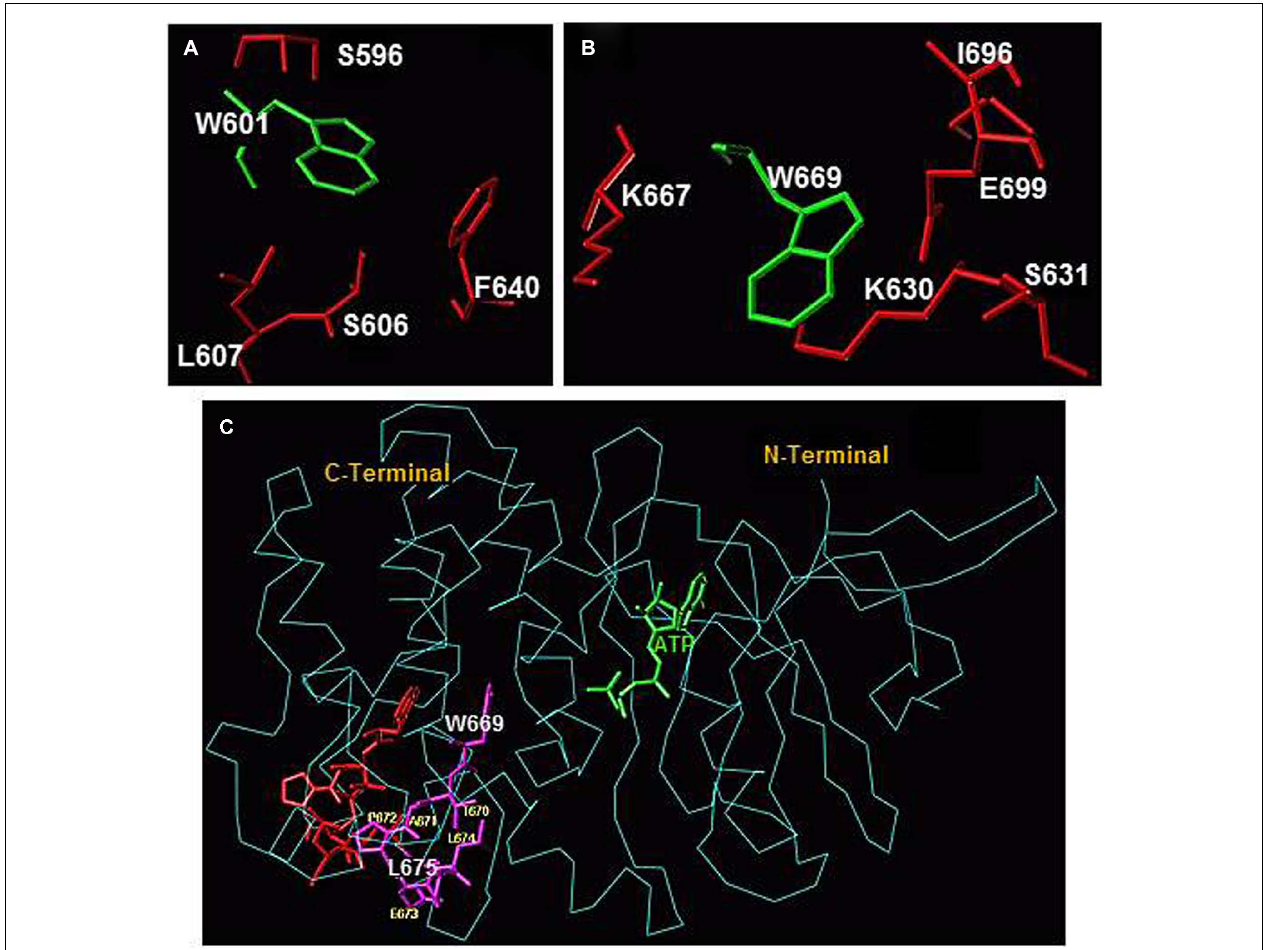
FIGURE 2 | (A) Amino acid residues surrounding W 601 and (B) amino acid residues surrounding W 669 within the ARM domain. Amino acid residues depicted in red are located within a 4 Åsphere from the respective tryptophan residue (green). (C) Conformational changes within the 669 WTAPELL 675 motif induced by ATP binding to the ARM domain. The backbone structure of the ATP-bound ARM domain is shown in cyan and the ATP molecule is in green. The 669 WTAPELL 675 motif is shown in magenta color. Apo structure of the ARM domain was superimposed on the ATP-bound form to assess the relative, ATP binding induced, conformational changes. For clarity, only the 669 WTAPELL 675 motif (shown in red) of the apo-enzyme is visible. ATP binding results in a